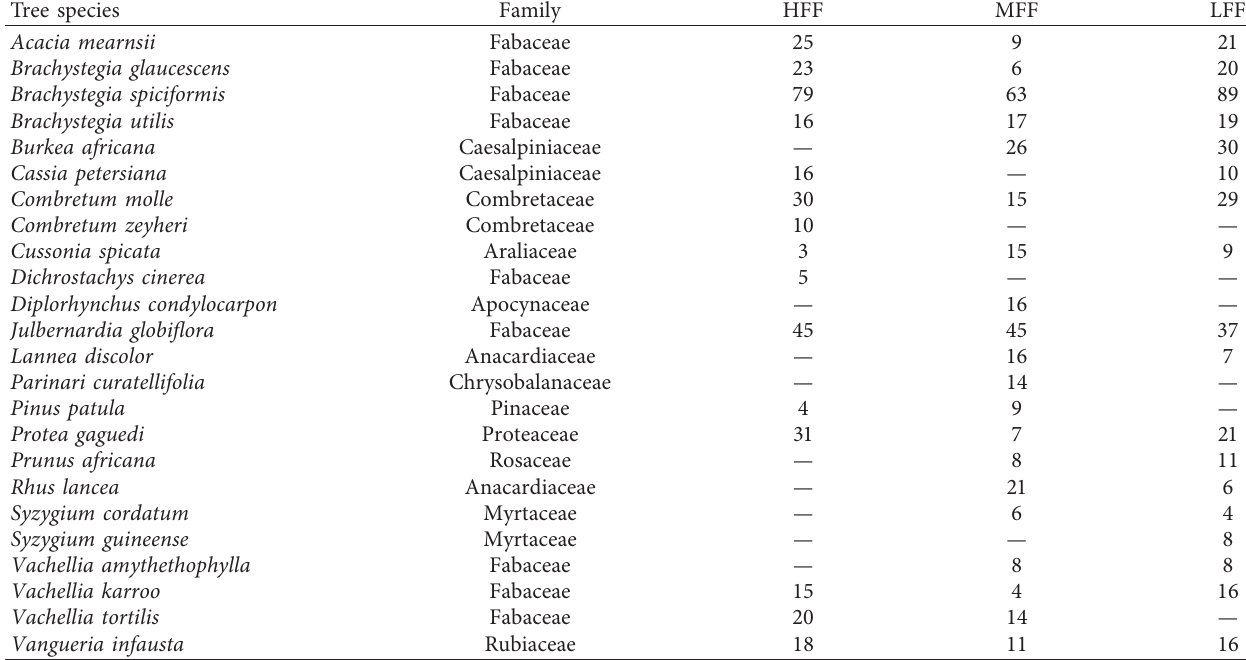
Table 2: Tree species (% occurrence) across the three fire frequency strata in Nyanga National Park. Tree species